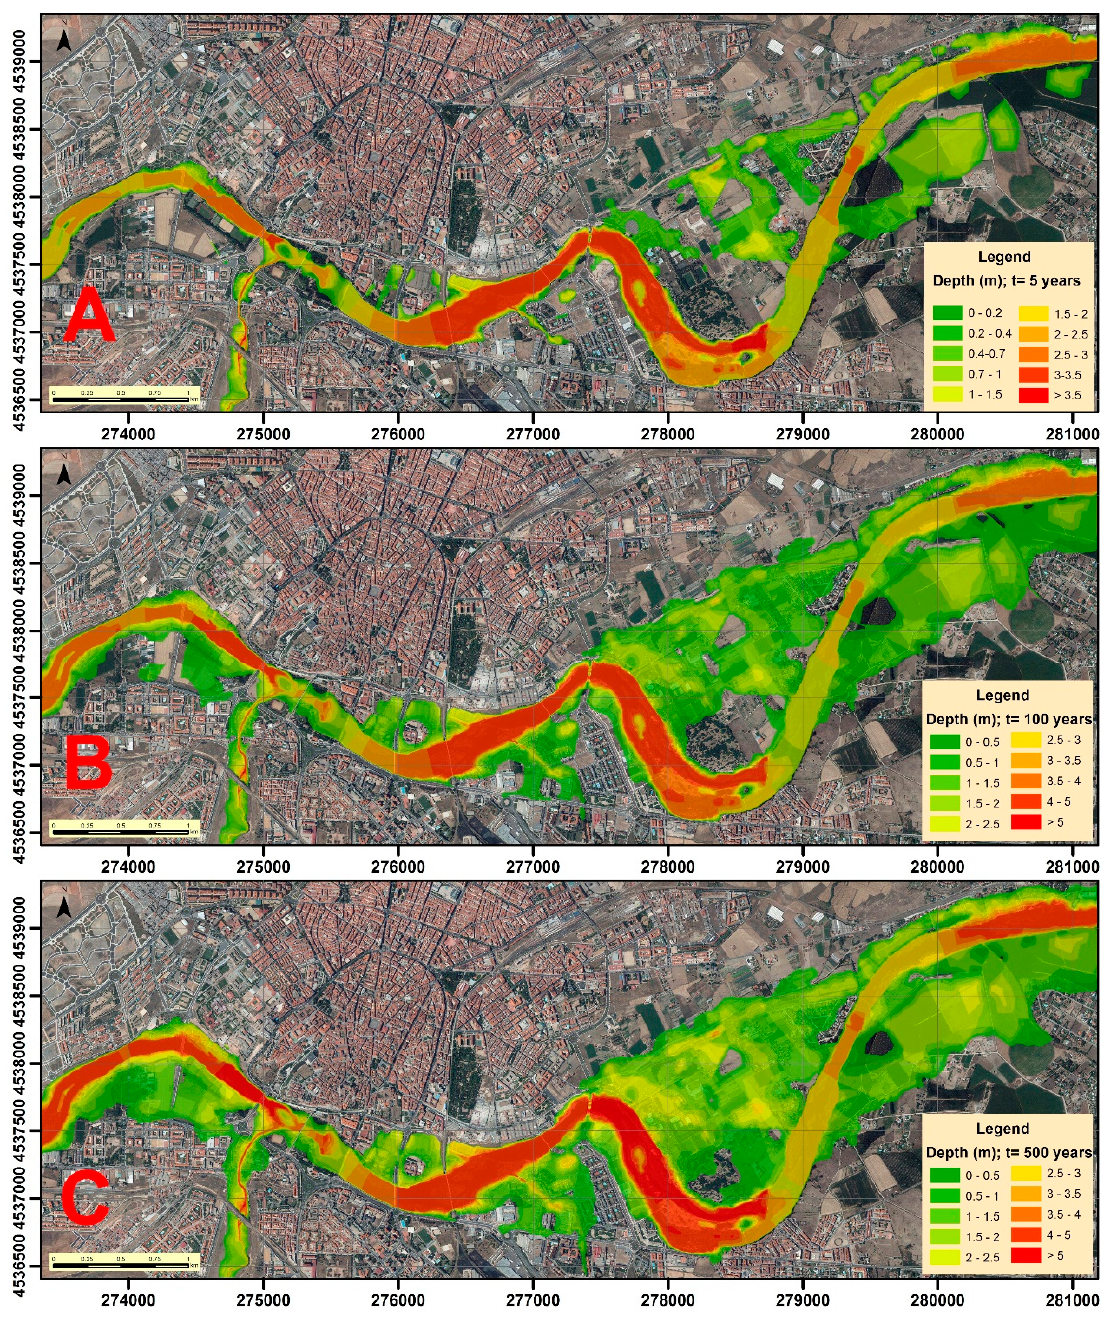
Figure 2. Water depth (m) in the different scenarios: ( A ) T = 5 years; ( B ) T = 100 years; and ( C ) T = 500 years.